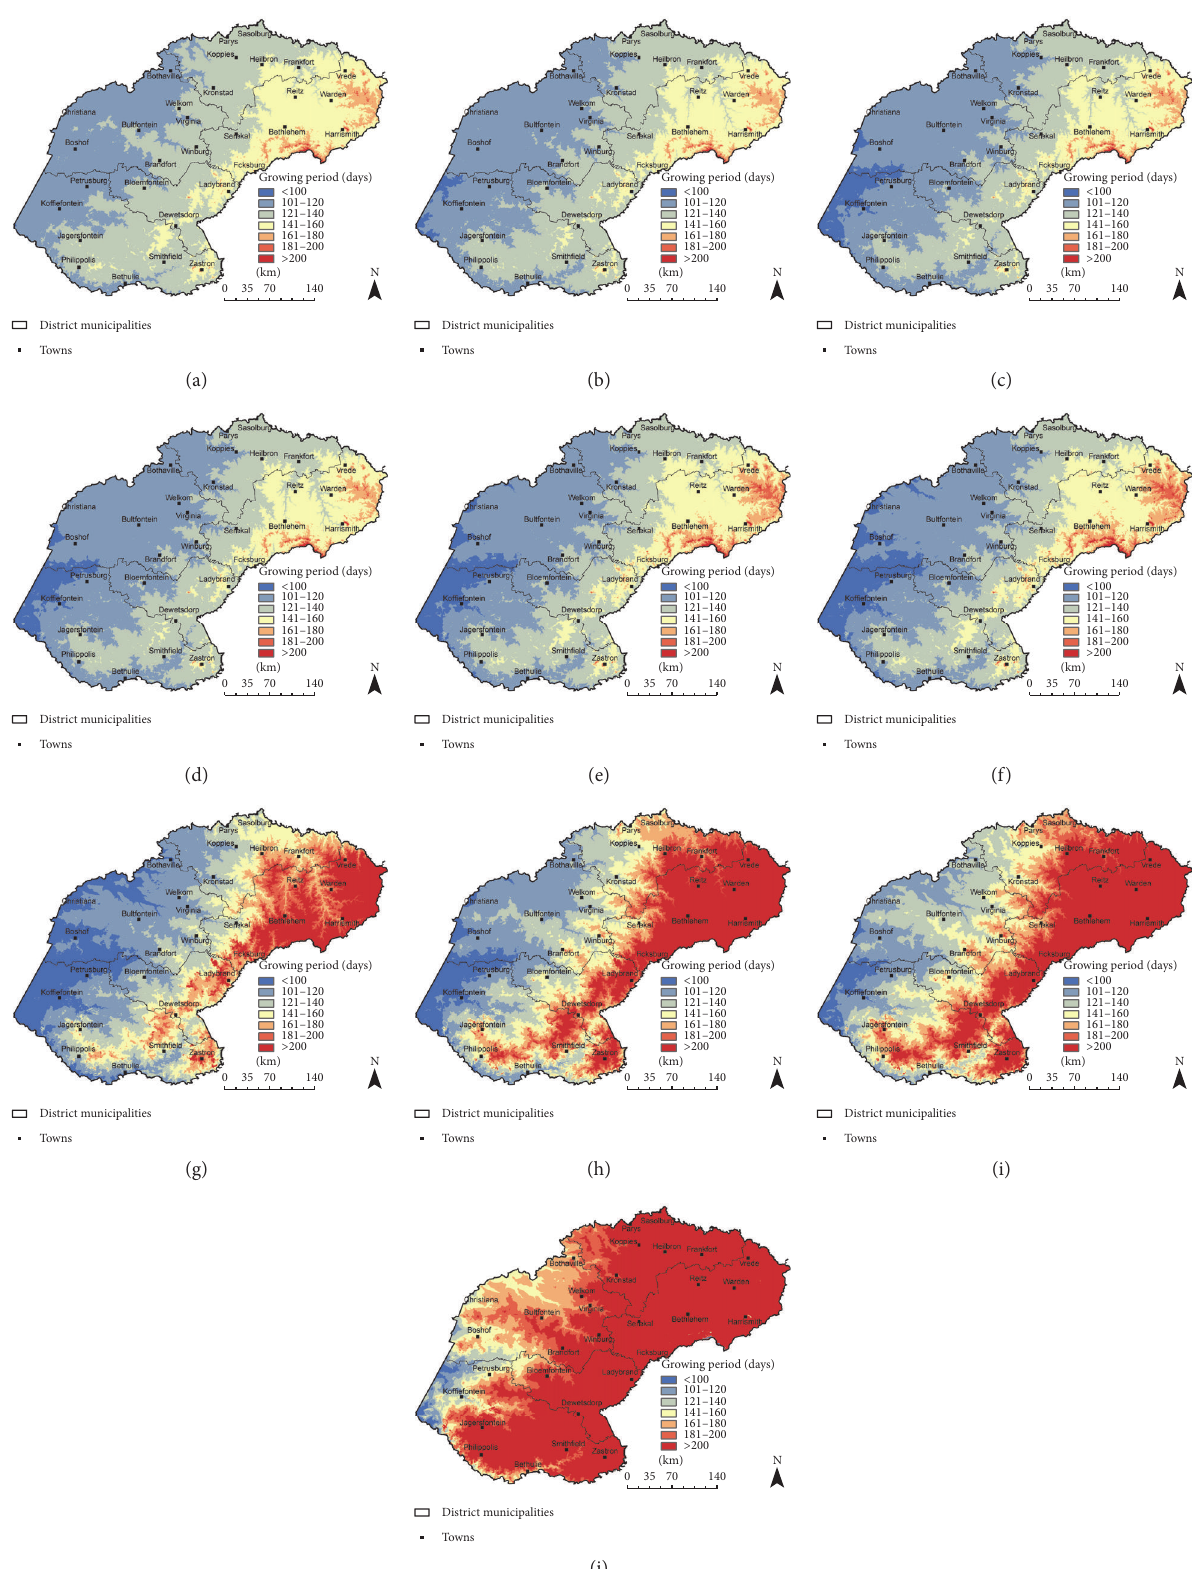
Figure 2: Growing period in days at 50% nonexceedence probability for a short season maize variety planted in the (a) 1st dekad of October, (b) 2nd dekad of October, (c) 3rd dekad of October, (d) 1st dekad of November, (e) 2nd dekad of November, (f) 3rd dekad of November, (g) 1st dekad of December, (h) 2nd dekad of December, (i) 3rd dekad of December, and (j) 1st dekad of